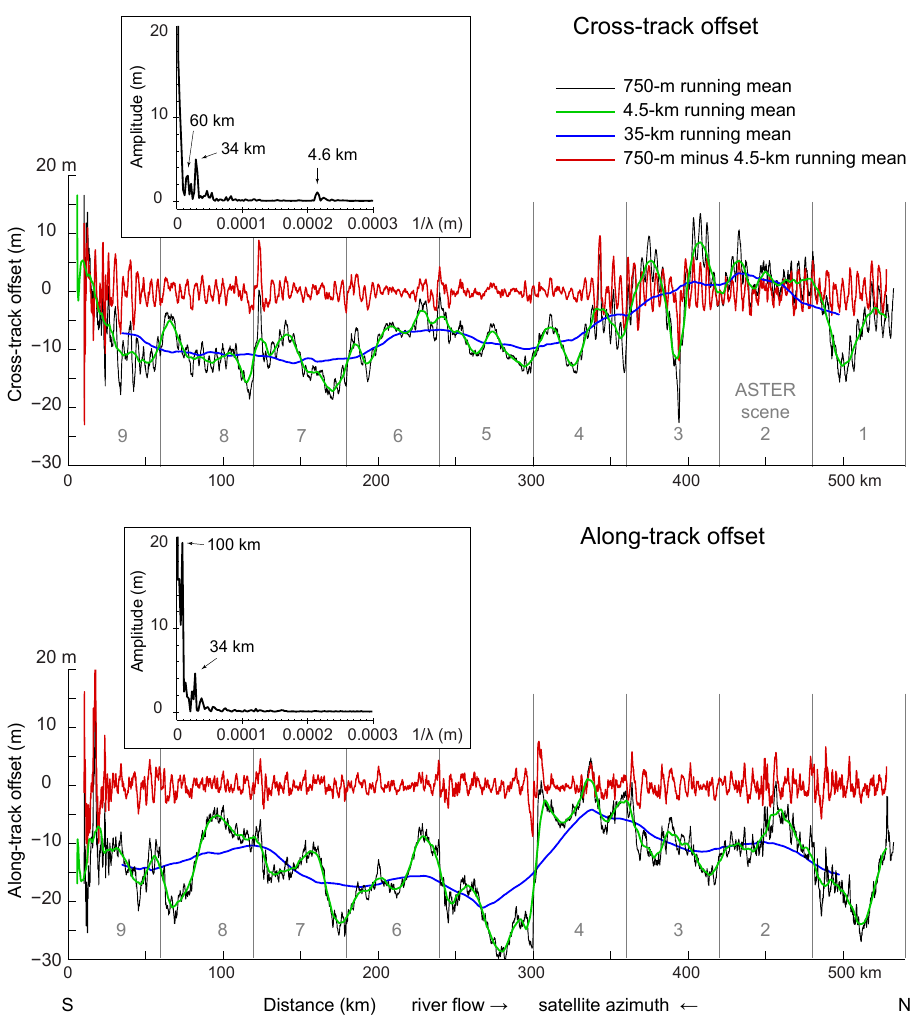
Fig. 5. Along-track profile of offsets between the nadir and back-looking data 3N and 3B on stable ground around the river. Offsets are shown as cross-track and along-track components. Black lines indicate offsets from a 750m running mean, green from a 4.5km running mean, and blue from a 35km running mean. Red lines are the residual offsets if the 4.5km running mean (green) is subtracted from the 750m running mean (black). Insets show the power spectra of the 750m running means, with most dominant wavelengths marked by arrows. The 4.6km wavelength is well visible in the red line in the cross-track offset component, the 34km wavelength in the green lines, and the 60 or 100km wavelengths, respectively, in the blue